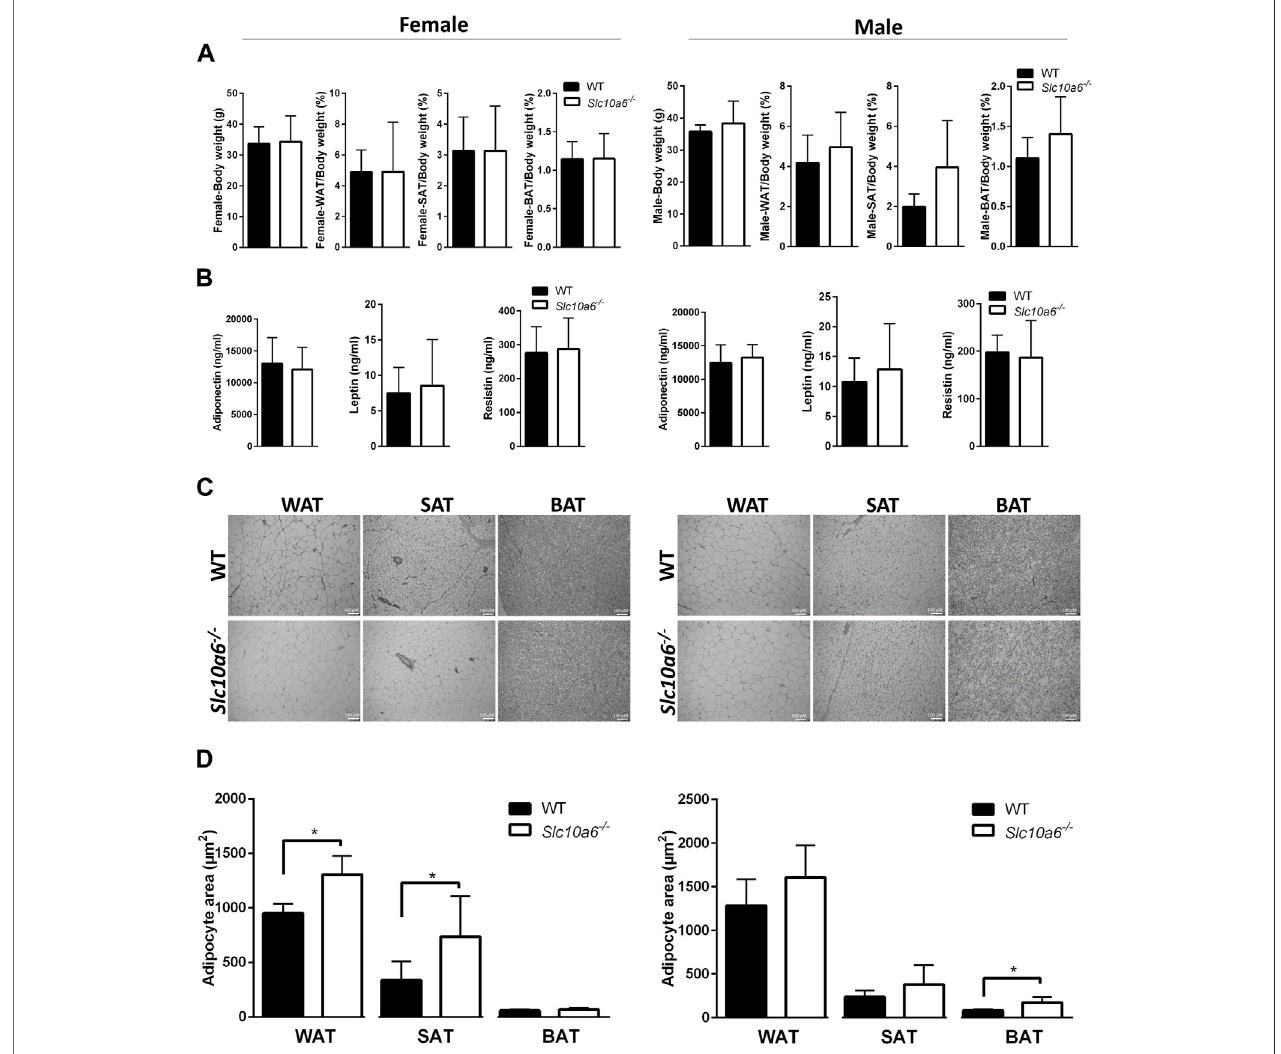
FIGURE 2 | Effects of Soat knockout on body weight, fat tissue weight, and adipocyte size. Adipose tissues of female (left panel) and male (right panel) WT and Slc10a6 − / − knockoutmice wereanalyzed. (A) Weightofadiposetissues(WAT,SAT,and BAT)wasnormalized fortotalbody weight.Results areshown asmeans±SD. (B) Serum levels of adiponectin, leptin, and resistin. Data are presented as means ± SD of n = 4 female and n = 6 male mice per genotype. (C) Histological presentation and (D) quantitative examination of WAT, SAT, and BAT cell morphology. Histological slides after H&E staining were used for quantitative analysis of the mean adipocyte size expressed in µm 2 . Scale bars: 100 μ m. Dataare presented as mean ± SD. *Signi fi cant differences between WT and Slc10a6 − / − knockout miceindicated by p < 0.05 according to Student ’ s t-test. WT, wild type; WAT, white adipose tissue; SAT, subcutaneous adipose tissue; BAT, brown adipose tissue.